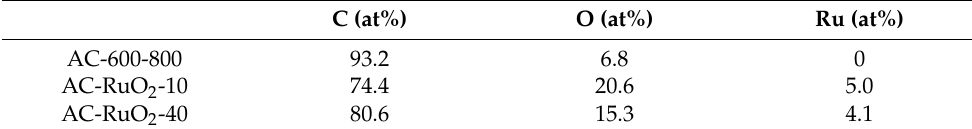
Table 4. XPS results of different samples AC-600-800, AC-RuO 2 -10, and AC-RuO 2 -40.